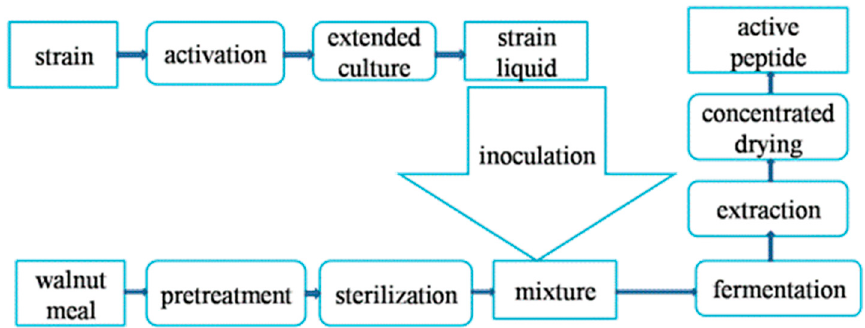
Figure 1. Technological process of preparing WBP by solid fermentation.